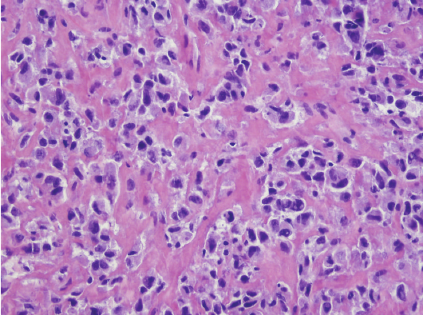
Figure 6: Biopsy of enlarging pelvic mass showed a sarcoma comprised of high grade round to epithelioid cells (hematoxylin and eosin stain, 40x).